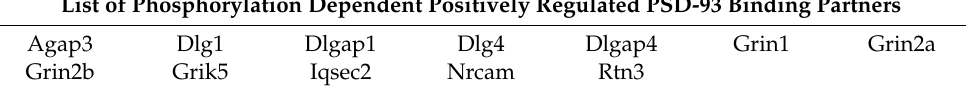
Table 1. Phosphorylation-dependent positively regulated PSD-93 binding partners. LC-MS/MS data were sorted according to two criteria: 1. the sample-control vs. IgG-control ratio was 10:1; and 2. binding with PSD-93 was greater upon calyculin A stimulation than under the sample-control condition or Y-27632 stimulation. The list shows the proteins that were positively regulated upon the phosphorylation of PSD-93 by Rho-kinase.